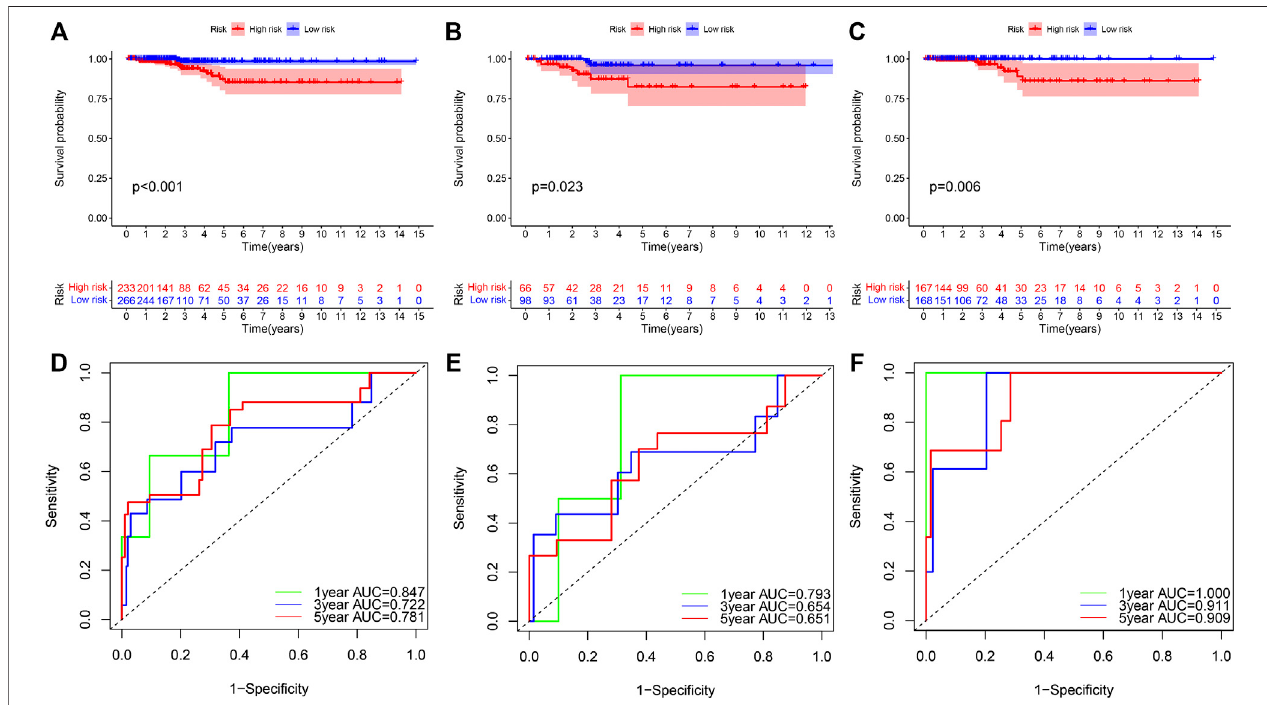
FIGURE6| Cross-validationofaprognosticmodelinTHCA. (A – C) OSanalysisofTHCApatientswithhigh-andlow-RSinthecombinedtest,andtrainingcohorts, with p < 0.001, p (cid:1) 0.023, and p (cid:1) 0.006, respectively. (D – F) ROC curve analysis for 1 − , 3 − , 5-years validation of RS model in three different cohorts. THCA, thyroid carcinoma; OS, overall survival; RS, risk score; ROC, receiver operating characteristic.